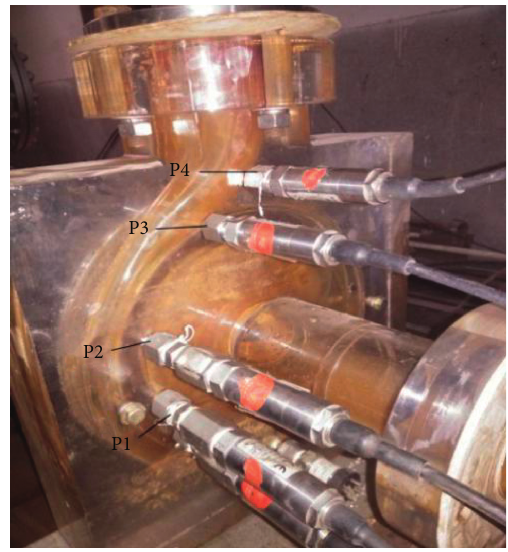
Figure 1: Test monitoring points. Table 1: Basic parameters of the guide vane centrifugal pump.